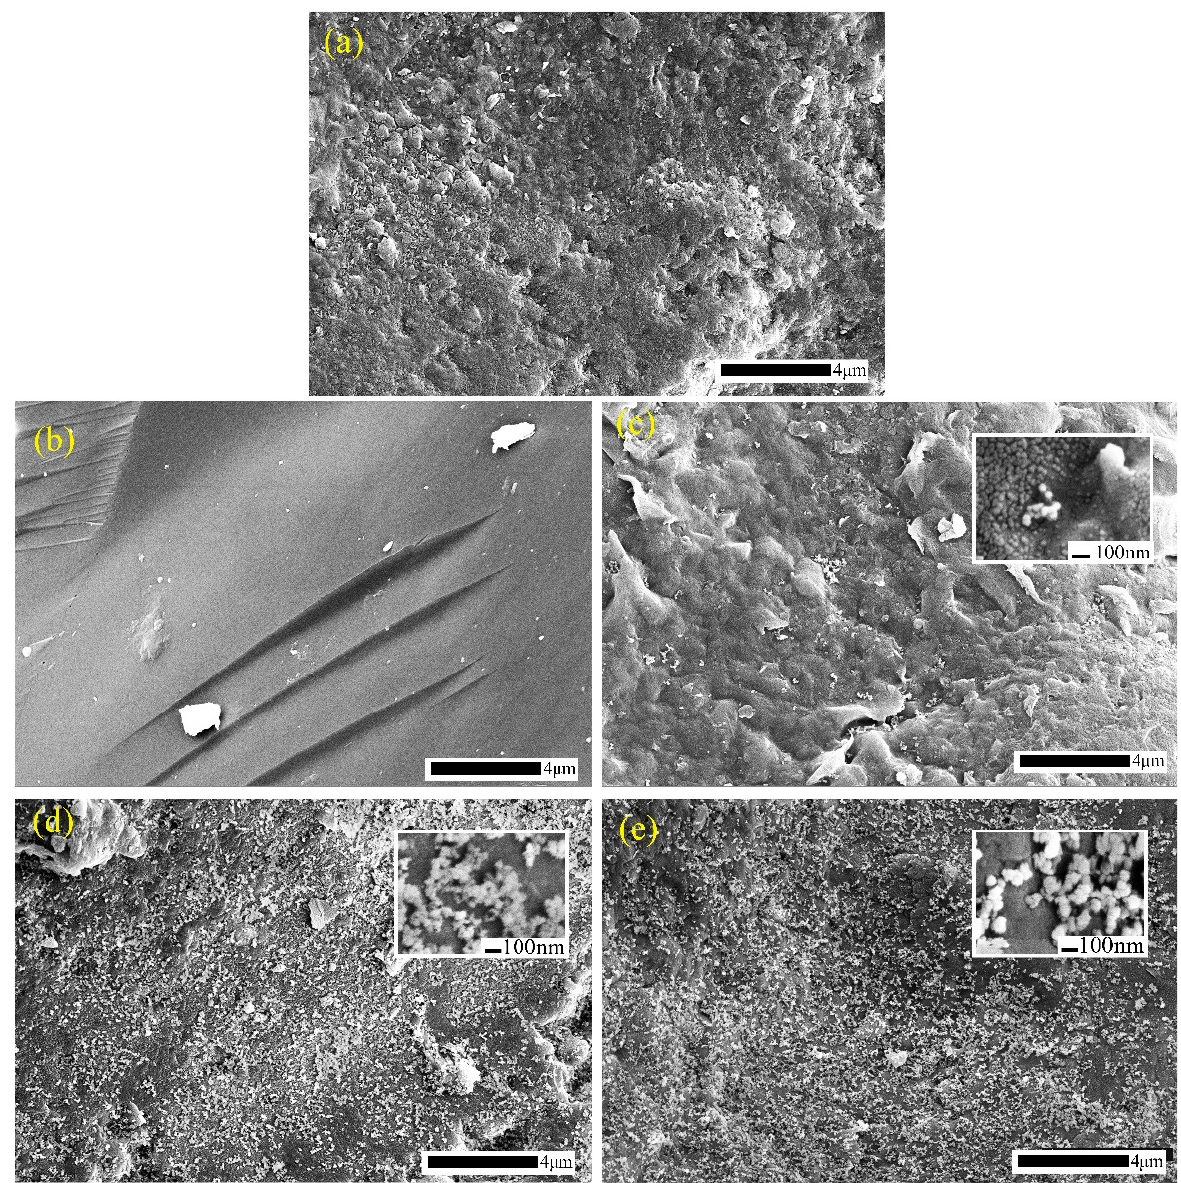
Figure 4. SEM images: ( a ) S, ( b ) D, ( c ) DT, ( d ) DS, and ( e ) DST. A higher-magnification image is depicted in ( c , d ), and ( e ) in the upper right corner.